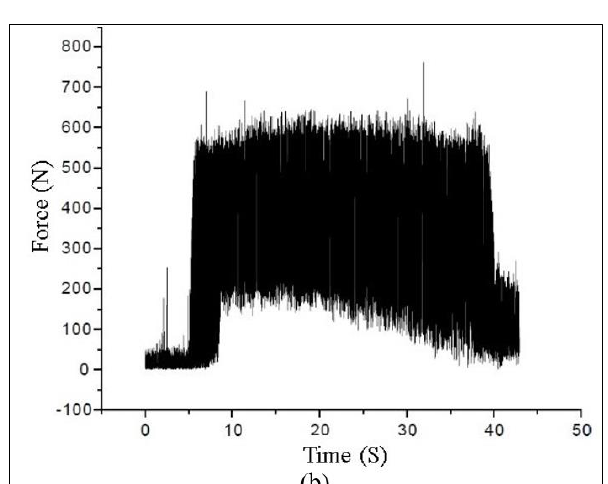
Figure 12a: Sample without sealant (nose radius 0,8 mm): (a) Machined surfaces.